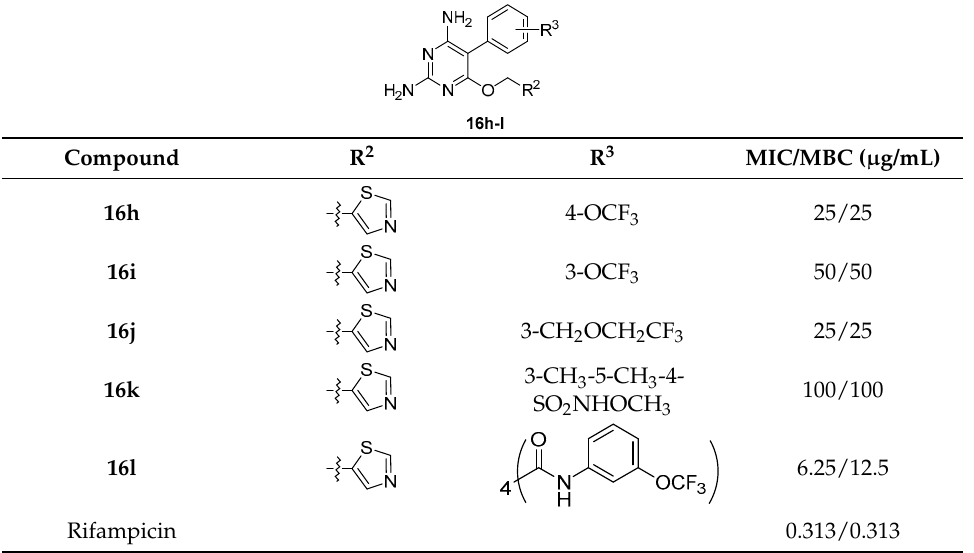
Table 2. Minimum inhibitory concentrations (MIC) and minimum bactericidal concentrations (MBC) of compounds 16h – l showing anti-tubercular activity.